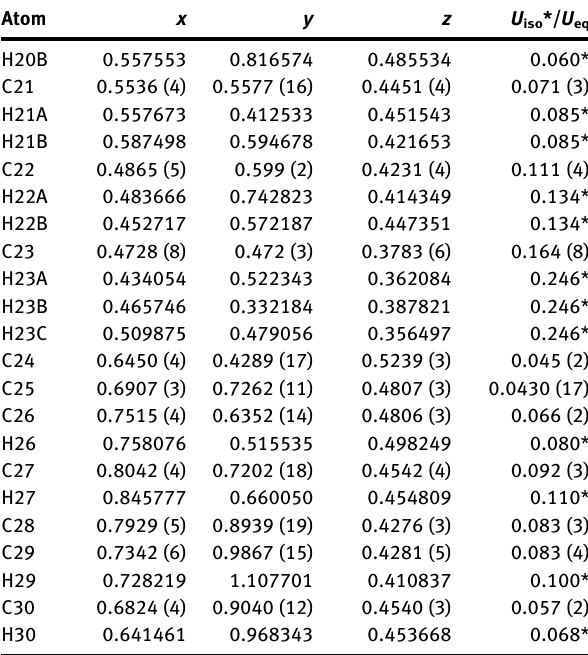
Table  : Fractional atomic coordinates and isotropic or equivalent isotropic displacement parameters (Å 